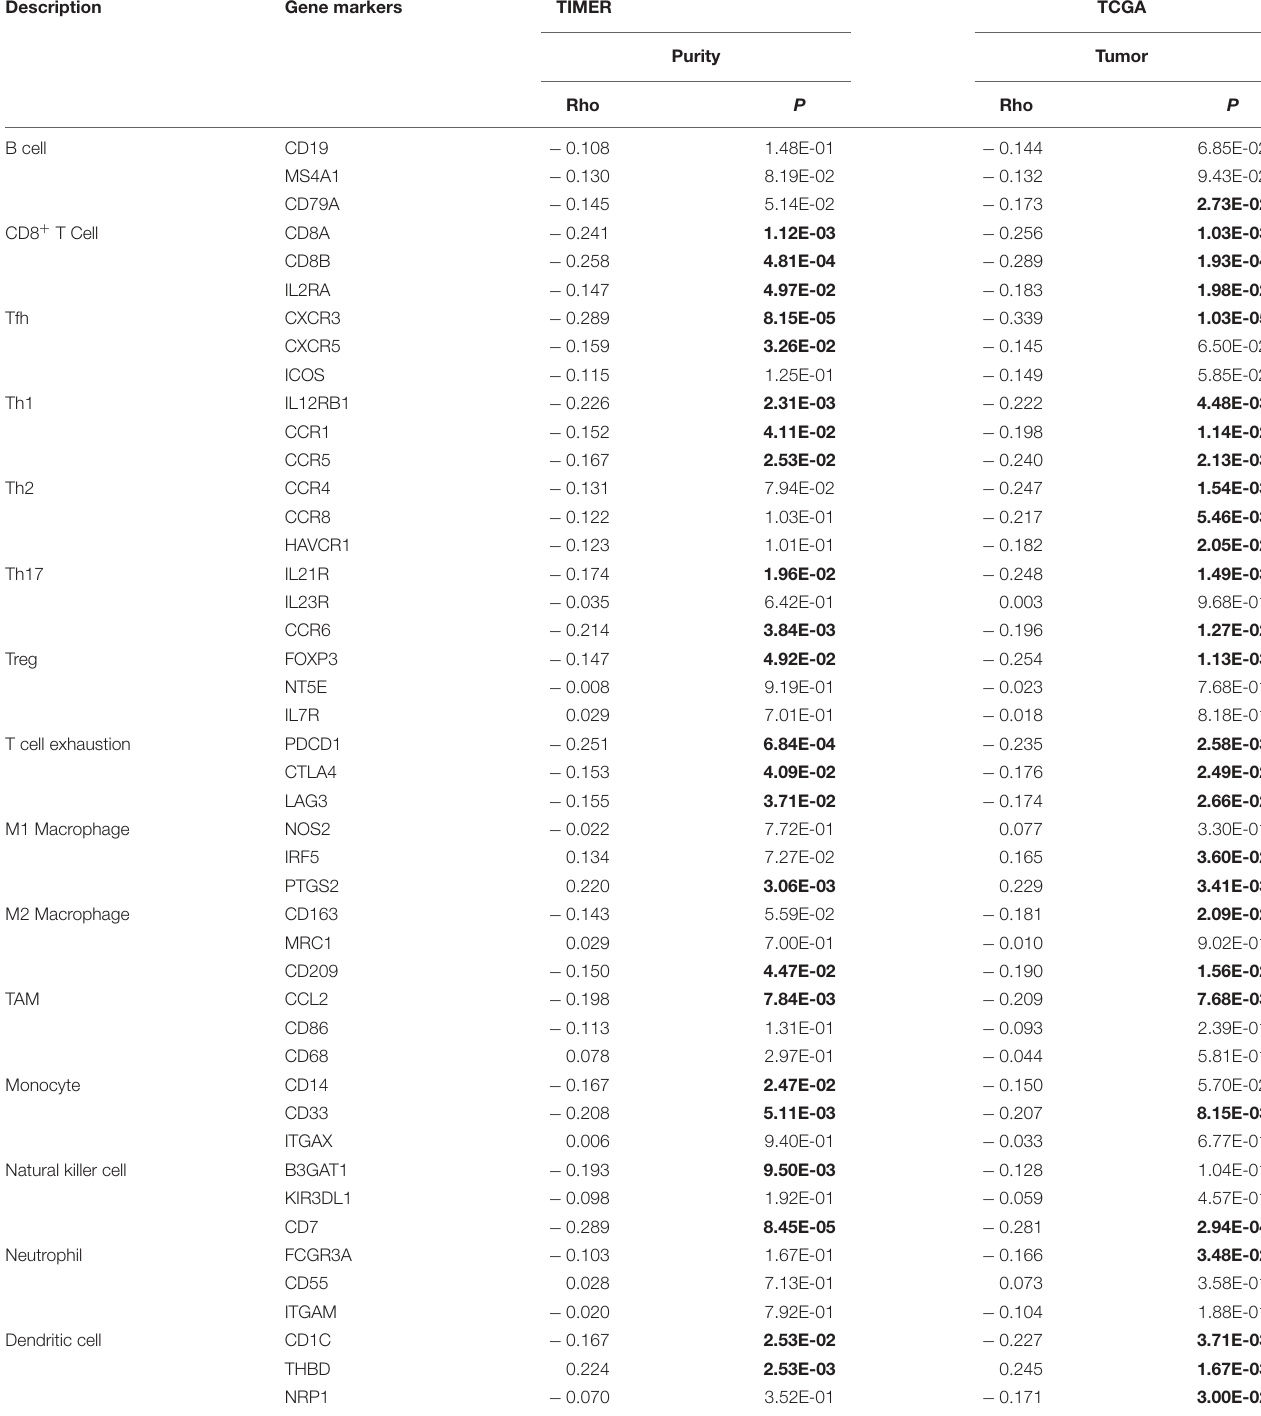
TABLE 2 | Correlation analysis between HK2 and immune cell marker gene in TIMER and TCGA.